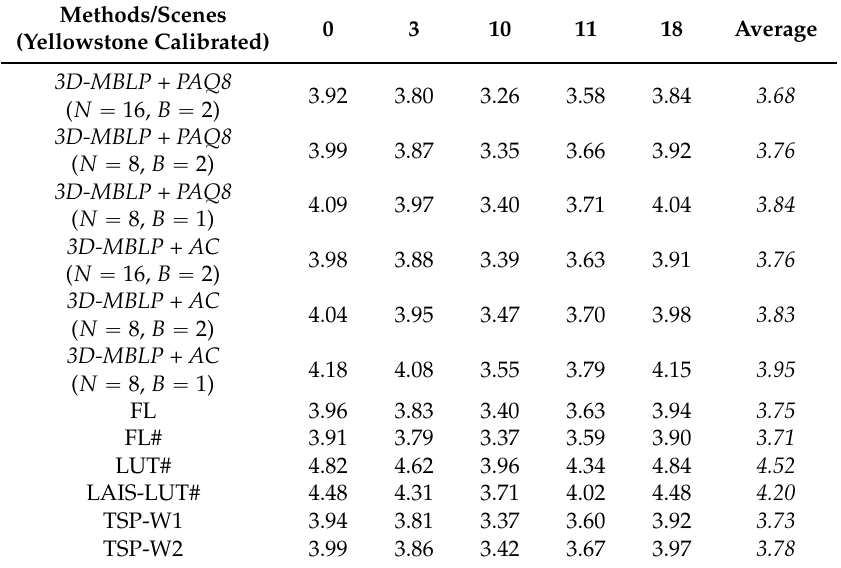
Table 14. Comparison with other lossless compression methods (calibrated images). The results are reported in bits-per-sample